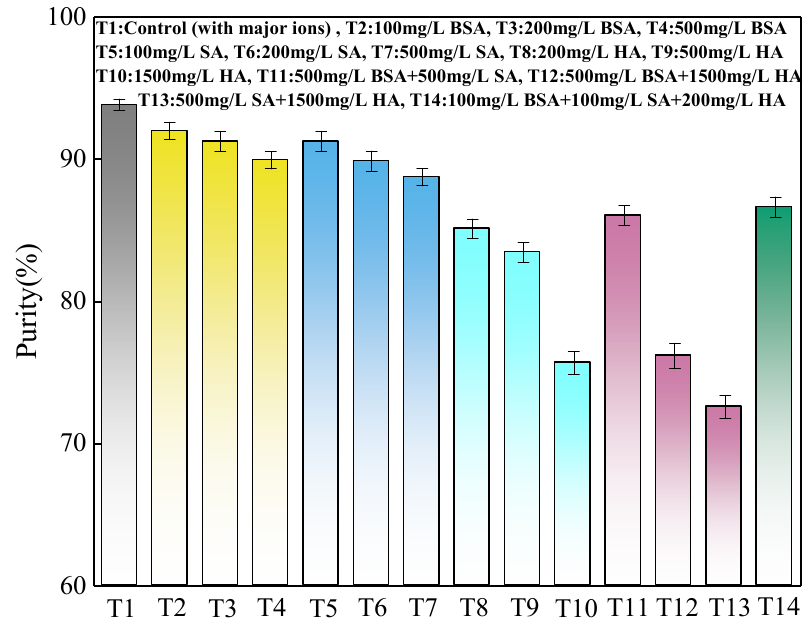
Figure 11. Struvite purity in the precipitates.